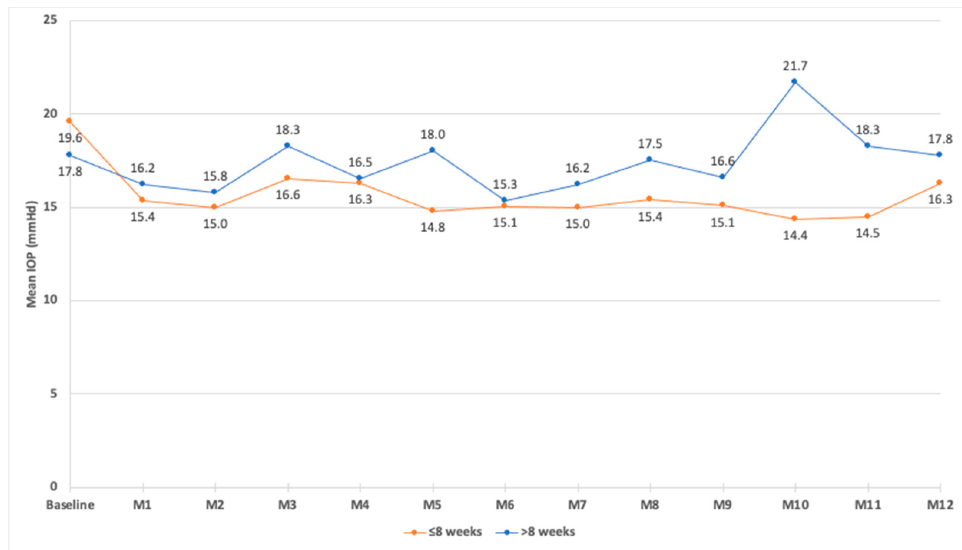
Figure 6. Mean intraocular pressure (IOP) during the follow-up in eyes that received their last dexamethasone intravitreal implant injection ≤ 8 weeks or >8 weeks before the first injection of fluocinolone acetonide implant.